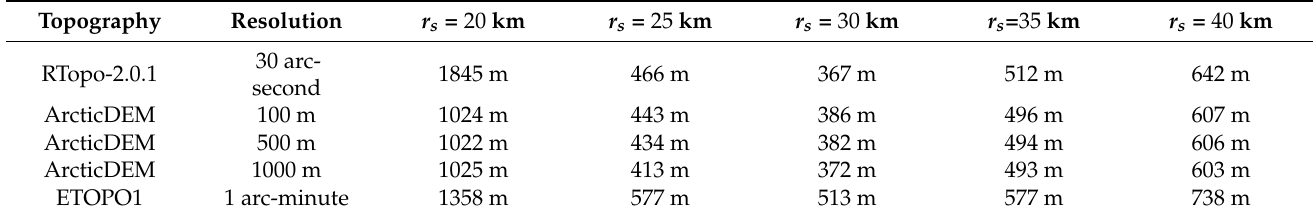
Table 3. Comparison of the effect of different resolutions of DEM on the